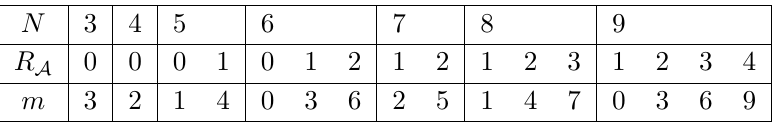
Table 2 . Allowed amplitudes for small total number of particles N = m + n